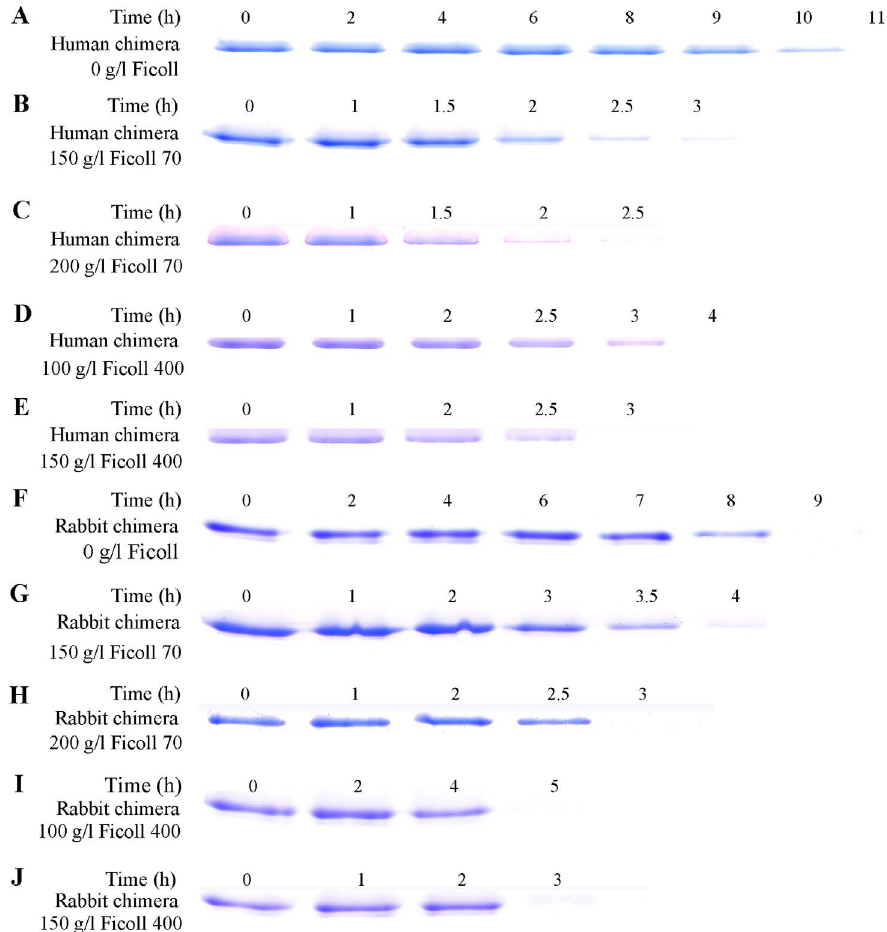
Figure 2. Time-dependent SDS-PAGE analysis of Sarkosyl-soluble human chimera (A–E) and rabbit chimera (F–J) of prion proteins incubated in 0 g/l Ficoll (A and F), 150 g/l (B and G) and 200 g/l (C and H) Ficoll 70, and 100 g/l (D and I) and 150 g/l (E and J) Ficoll 400. We took and dialyzed the samples against 10 mM Tris-HCl (pH 7.0), and incubated them with 10 mM Tris-HCl buffer containing 2% Sarkosyl for 30 min. Then we centrifugated the samples at 17,000 g for 30 min and mixed the supernatants with 2 6 loading buffer and separated them by 15% SDS-PAGE. The human/rabbit PrPs were denatured in PBS buffer (pH 7.0) containing 2 M GdnHCl.